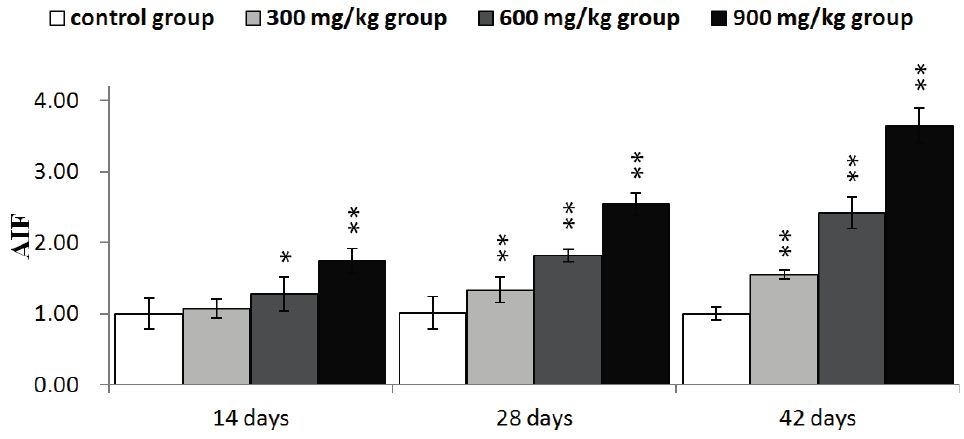
Figure 7. The protein expression levels of AIF and EndoG in the kidney. Data are presented with the mean ± standard deviation ( n = 5 × 5); * p < 0.05, compared with the control group; ** p < 0.01, compared with the control